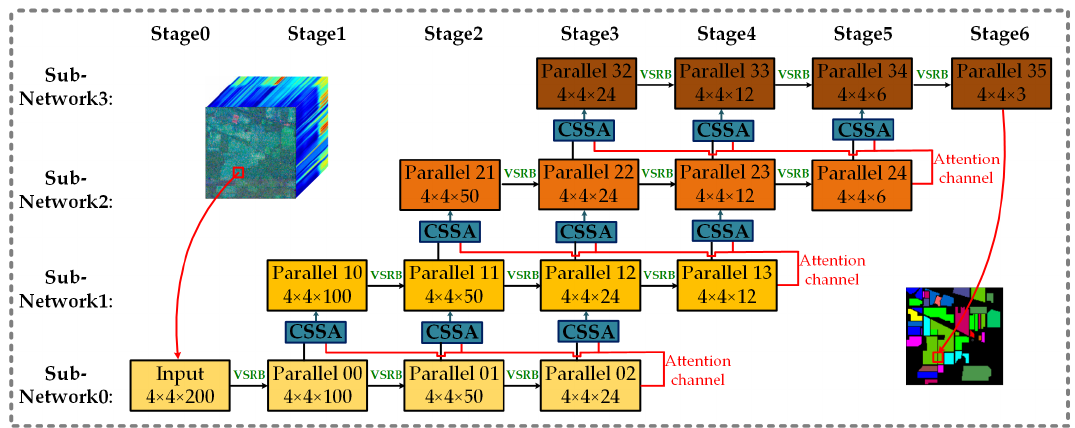
Figure 2. Channel–spectral–spatial-attention parallel network. Each row and column represents the same subnetwork and the same convolution stage, respectively; VSRB represents the variable spectral residual block; CSSA represents the channel–spatial–spectral-attention